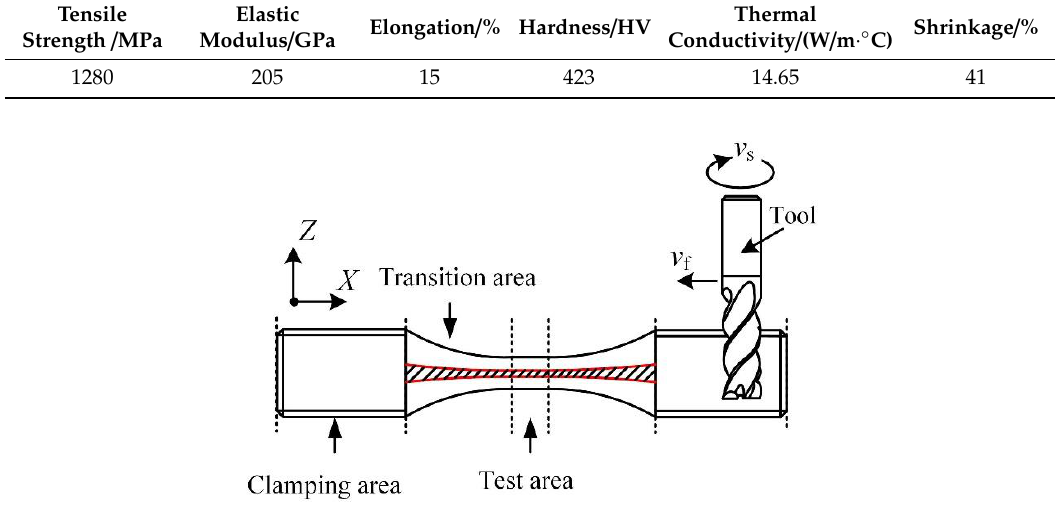
Figure 2. Side and down milling diagram.